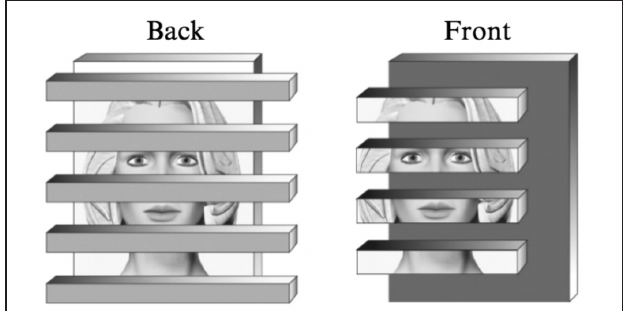
FIGURE 2 | Illustration of the face recognition experiment of Nakayama et al. (1989). When the face is in back, it is easy to identify, but when the face strips are in front, the system assigns their borders to the strips, thus grouping the face information with the horizontal borders, and face identification becomes difficult. The illustration uses pictorial tools to depict depth, in the experimental study depth was defined by stereoscopic presentation. (Reproduced with permission from Nakayama and Shimojo,